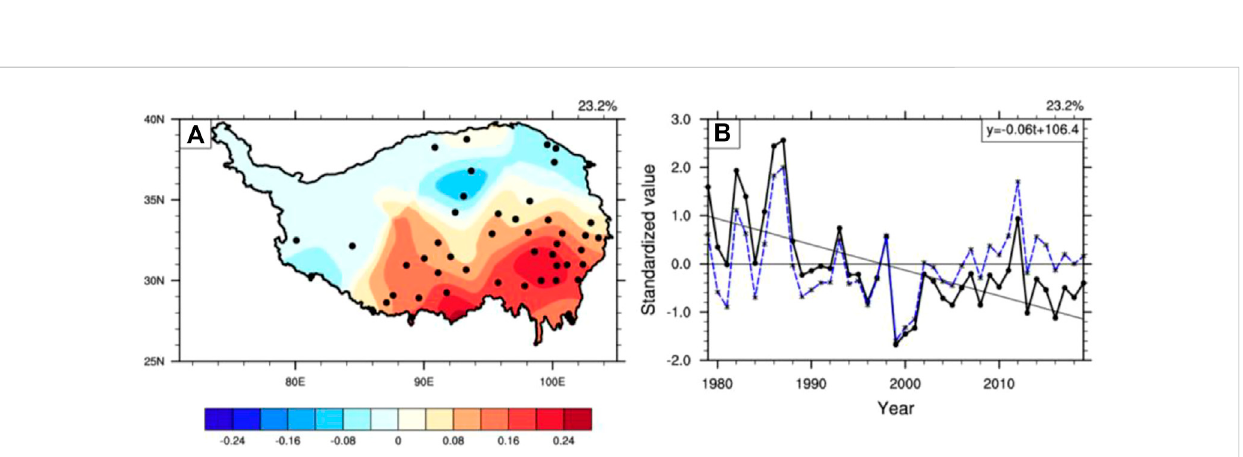
TP;thedottedbluelineindicatesthedetrendvariation.Theslopingblacklinedenotesthelineartrendofthecorrespondingtimeseries,indicatingthatthe spring SH over the TP decreased at a rate of 0.6 (W · m − 2